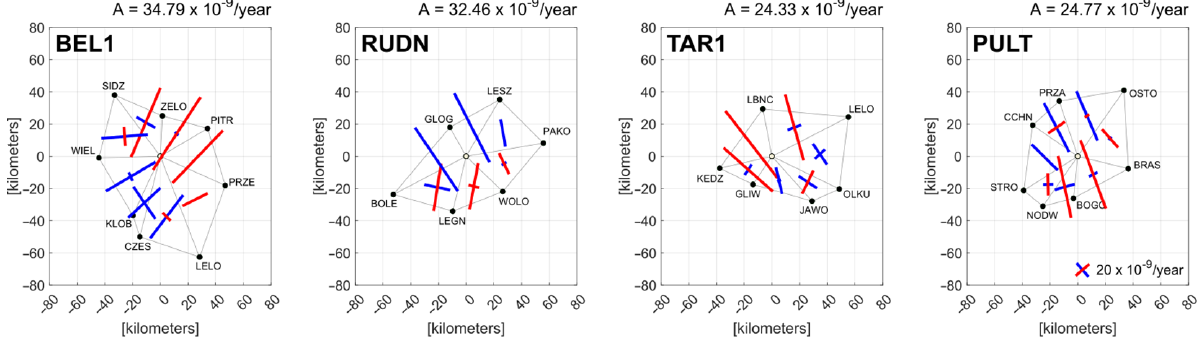
Figure 7. GPS strain rate distribution around sample stations recognized as a deviating station, with the value of the amplitude (A) of the fitted sine function.